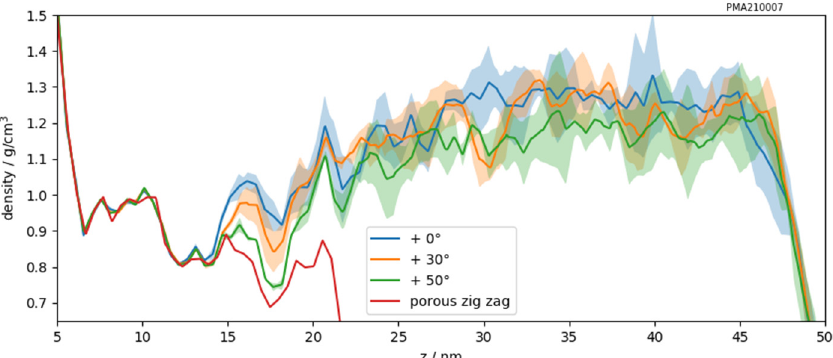
Figure 9. Density profiles in growth direction of SiO 2 structures. The lines present the mean values from each three structures with the shaded regions indicating the standard deviation. For comparison, the density profile for only the first layer is also given (red).